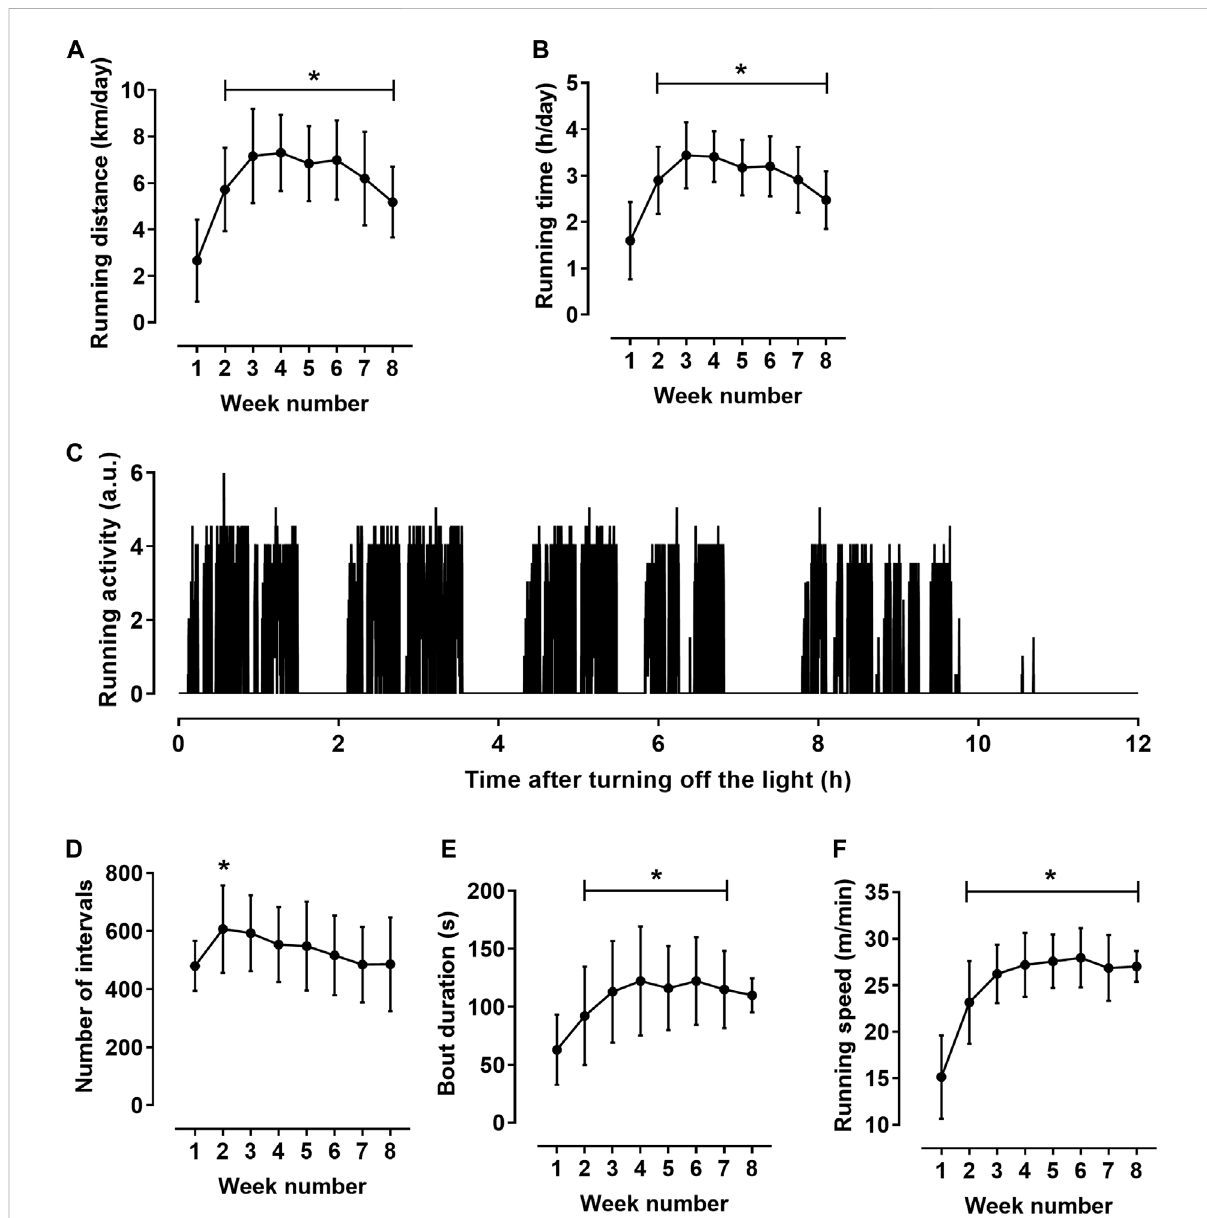
FIGURE 1 Characteristics of rat running activity during the 12-h dark period ( n = 11). (A,B) daily running distance (A) and running time (B) . (C) Pattern of running activity of one rat at the seventh week of the training cycle. The initial value on the horizontal axis corresponds to the lighting off (at 8: 00 p.m.); vertical axis shows the number of wheel half-revolutions in 5-s time intervals. (D – F) indicators calculated for individual bouts: numbers of bouts (D) ,meanboutduration (E) andmeanrunningspeedinbouts (F) duringthe8-weektrainingcycle.* p < 0.05comparedtothe fi rsttraining week (Repeated measures one-way ANOVA with Dunnett ’ s multiple comparisons